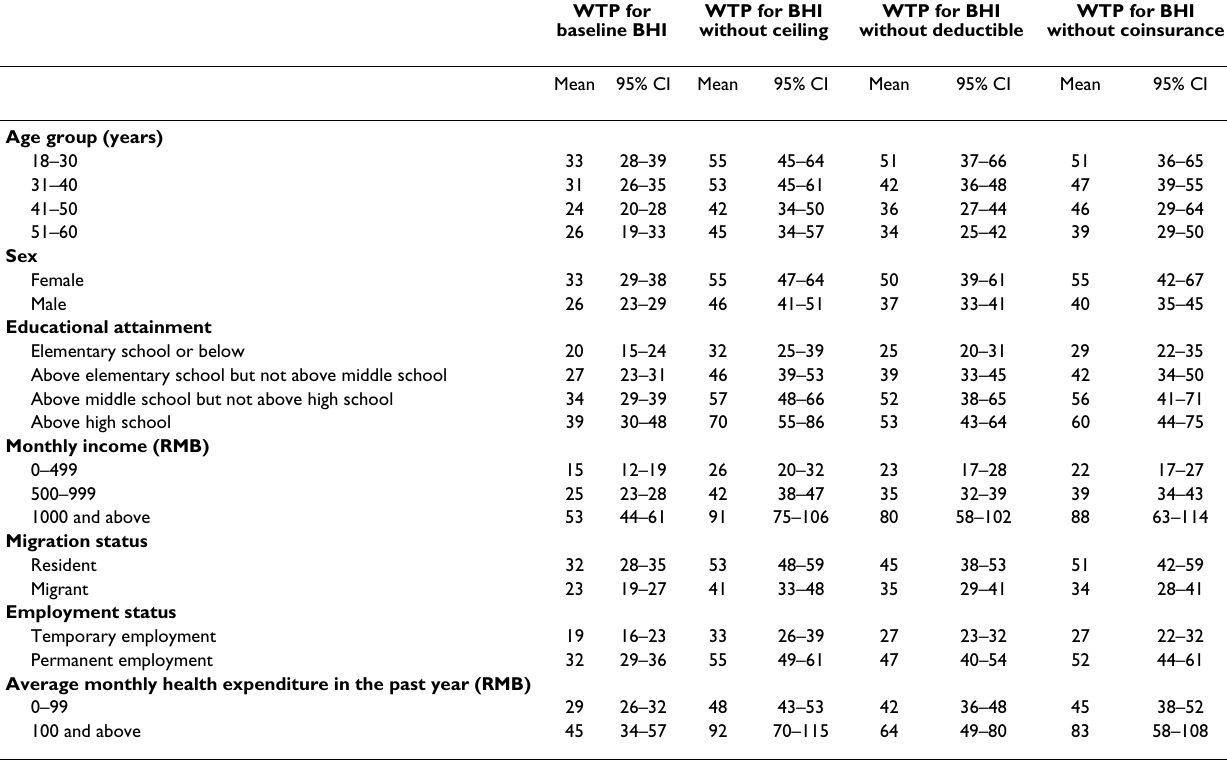
Table 3: Willingness to pay for basic health insurance by respondents' characteristics